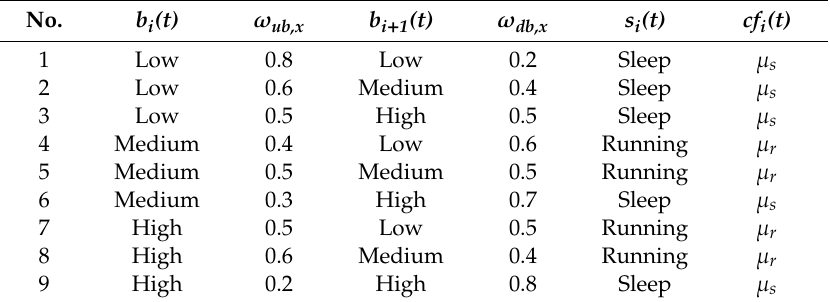
Table 1. Weighted adaptive fuzzy production rules for machine state decisions.